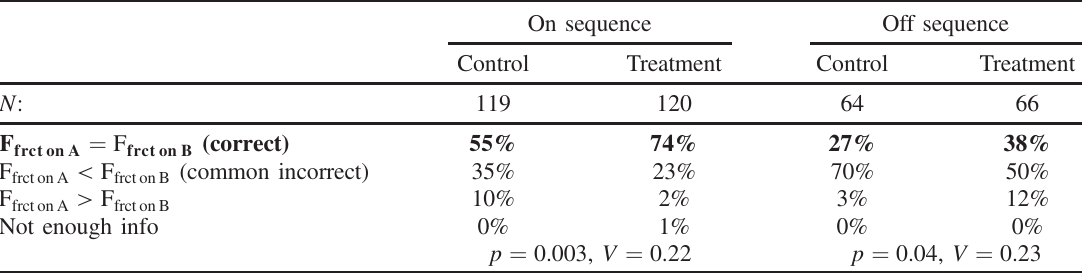
TABLE VII. Student answer distributions on both versions (control and treatment) of the chaining version of the two-box friction task (experiment 2A). The task itself is shown in Fig. 2(b). The correct answer choice is in boldface for reference.